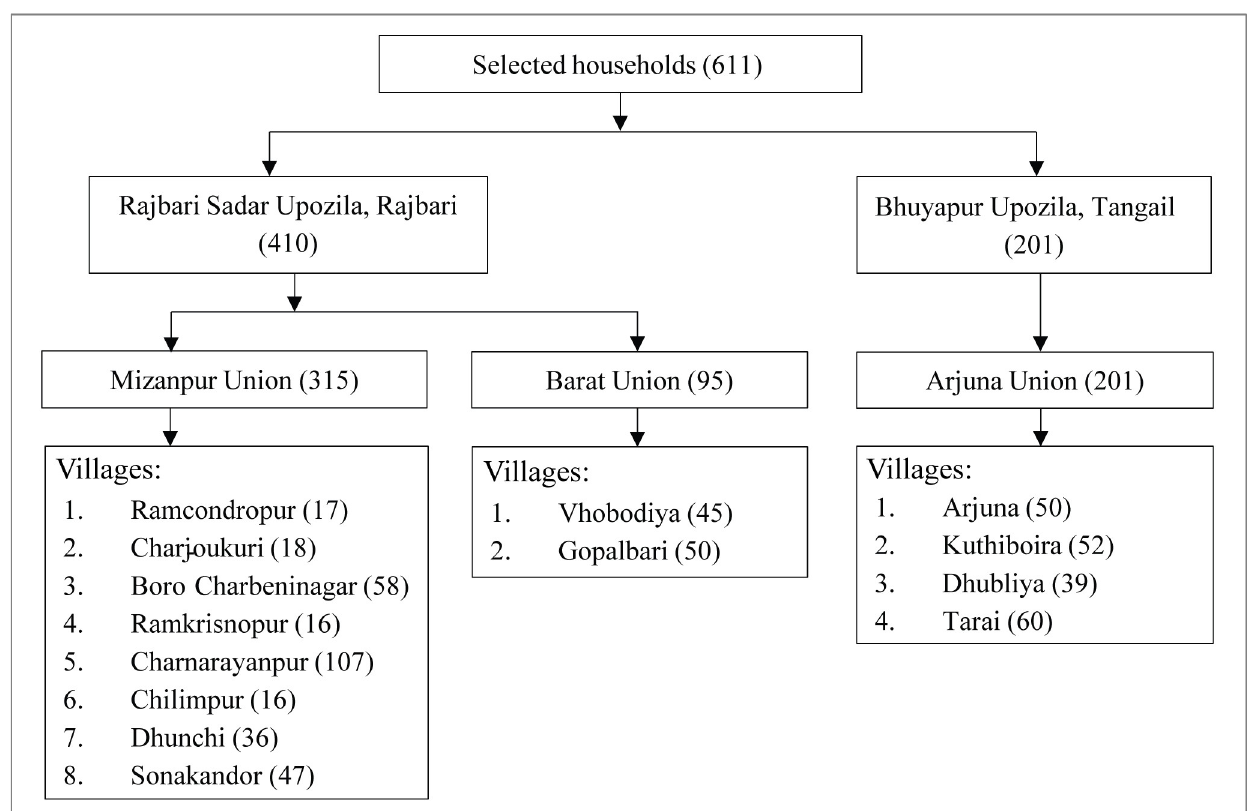
Fig 2. Distribution of the sampled